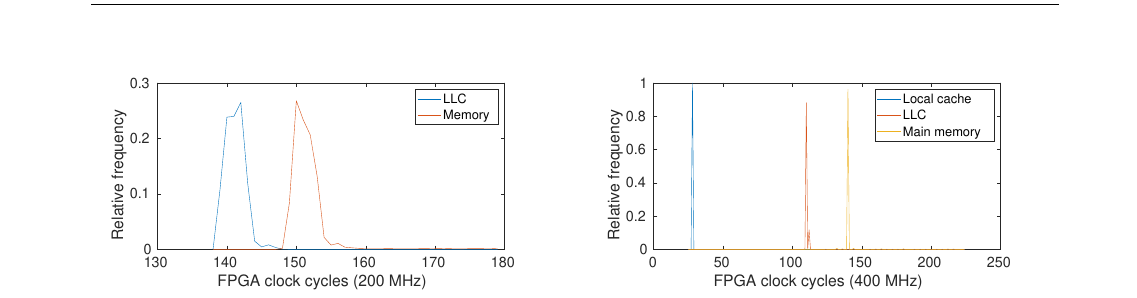
Figure 12: Latency for UPI read requests on an integrated Arria 10 served by the FPGA’s local cache, CPU’s LLC, or main memory.